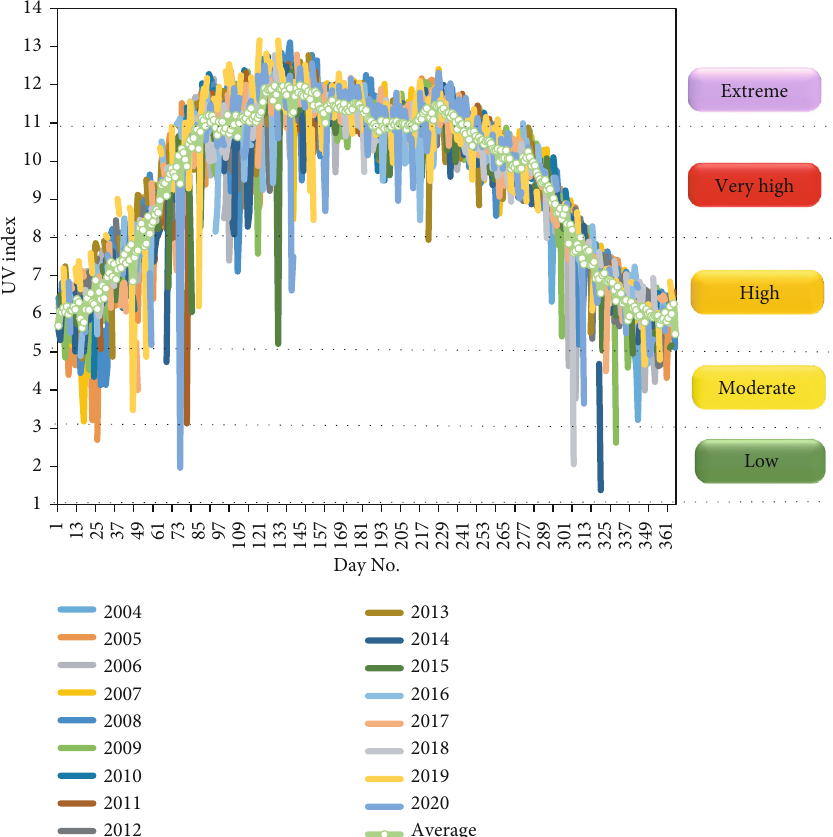
Figure 3: Daily average variation in UVI at KAS during the study